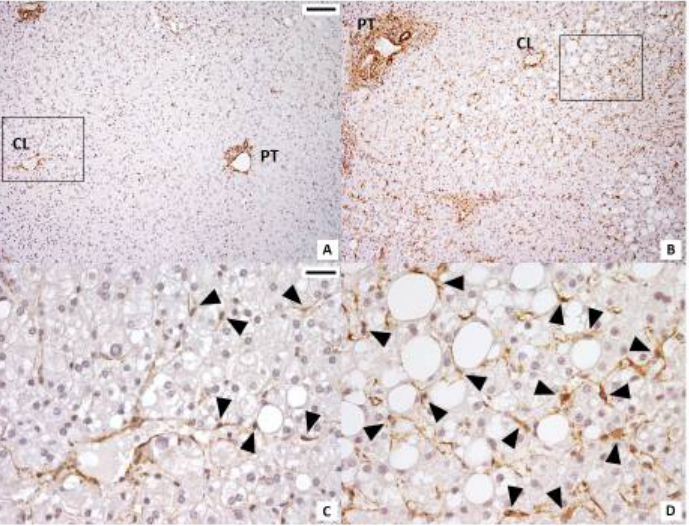
Figure 3. Immunohistochemistry for α -SMA in pre-ischemia liver biopsies. Steatotic hepatocytes Figure 3. Immunohistochemistry for ⍺ -SMA in pre-ischemia liver biopsies. Steatotic hepatocytes accumulate near the centrilobular vein. A larger number of ⍺ -SMA-positive hepatic stellate cells accumulate near the centrilobular vein. A larger number of α -SMA-positive hepatic stellate cells (arrowheads) were present near the centrilobular (CL) vein in samples in which Ld-MaS was (arrowheads) were present near the centrilobular (CL) vein in samples in which Ld-MaS was present present inside the hepatocytes. PT: portal tract. ( A , C ): liver lobule with Sd-MaS; B,D: liver lobule with Ld-MaS. Original magnification: ( A , B ) x100; ( C , D ) high-power fields X400. Scale bar: ( A , B ) inside the hepatocytes. PT: portal tract. ( A , C ): liver lobule with Sd-MaS; B,D: liver lobule with 200 µm; ( C , D ) 25 µm. The rectangles in panels A and B delimit the areas shown at higher Ld-MaS. Original magnification: ( A , B ) X100; ( C , D ) high-power fields X400. Scale bar: ( A , B ) 200 µ m; magnification in panels C and D, respectively ( C , D ) 25 µ m. The rectangles in panels A and B delimit the areas shown at higher magnification in 2.2.3. Multivariate Analyses of Factors Associated with Each Predominant Type of panels C and D, Steatosis vs. Nil-Steatosis We performed multivariate binary regression models to discover factors before LT independently associated with each predominant type of steatosis vs. nil-Steatosis. Predominant Ld-MaS compared to nil-Steatosis was significantly associated with donor age (O.R. 1.028 [CI 1.006–1.050]; p = 0.012) and donor BMI (O.R. 1.247 [CI 1.089–1.427]; p = 0.001). Regarding the donor PNPLA3 polymorphism, although the M allele was not associated with predominant Ld-MaS vs. nil-Steatosis, homozygosity (MM) compared to the wild type (II) was significantly associated with predominant Ld-MaS compared to nil- Steatosis in a dominant model (O.R. 4.261 [CI 1.017–17.845]; p = 0.047). With regard to the mRNA gene expression of lipid metabolism, predominant Ld-MaS compared to nil- Steatosis was significantly associated with low liver graft NPC1L1 (O.R. 0.137 [CI 0.031– 0.603]; p = 0.009), SREBP-2 (O.R. 0.762 [CI 0.600–0.968]; p = 0.026) and PNPLA3 (O.R. 0.916 [CI 0.844–0.995]; p = 0.038) mRNA expression (Figure 4). Predominant Sd-MaS compared to nil-Steatosis was significantly associated with donor BMI (O.R. 1.218 [CI 1.041–1.425]; p = 0.014) and length of ICU stay (O.R. 0.833 [CI 0.726–0.956]; p = 0.009). These data show that livers with predominant Ld-MaS compared to those without steatosis are independently associated with: (a) a more advanced age; (b) higher BMI; (c) being homozygous for the PNPLA3 polymorphism and lower expression of the protein encoded by the PNPLA3 gene, signs of abnormal lipolysis; and (d) lower expression of SREBP-2 and NPC1L1, indicating reduced activation of the cholesterol reabsorption pathway from bile. Regarding the comparison between livers without steatosis and those with predominant Sd-MaS, the latter are independently associated with: (a) a higher BMI; and (b) a shorter ICU stay, probably the expression of a shorter duration of undernutrition.